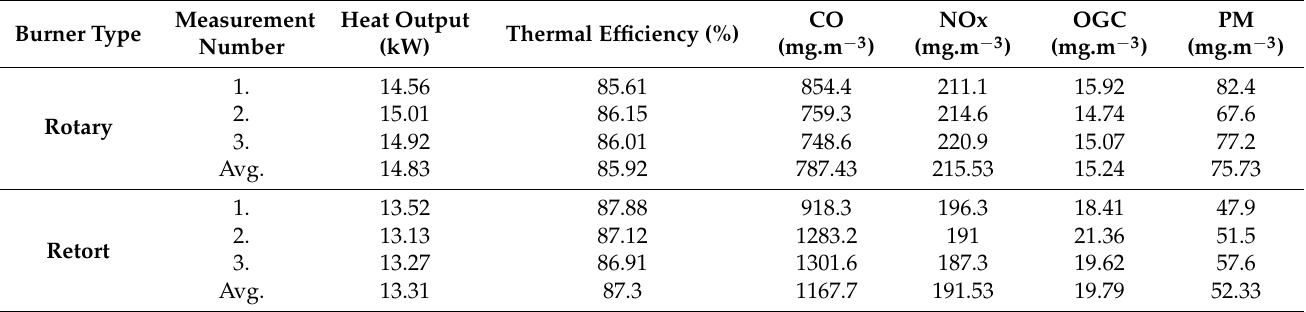
Table 1. Table 1. Results of measurements of performance and emission parameters of heat source for different types of burners.